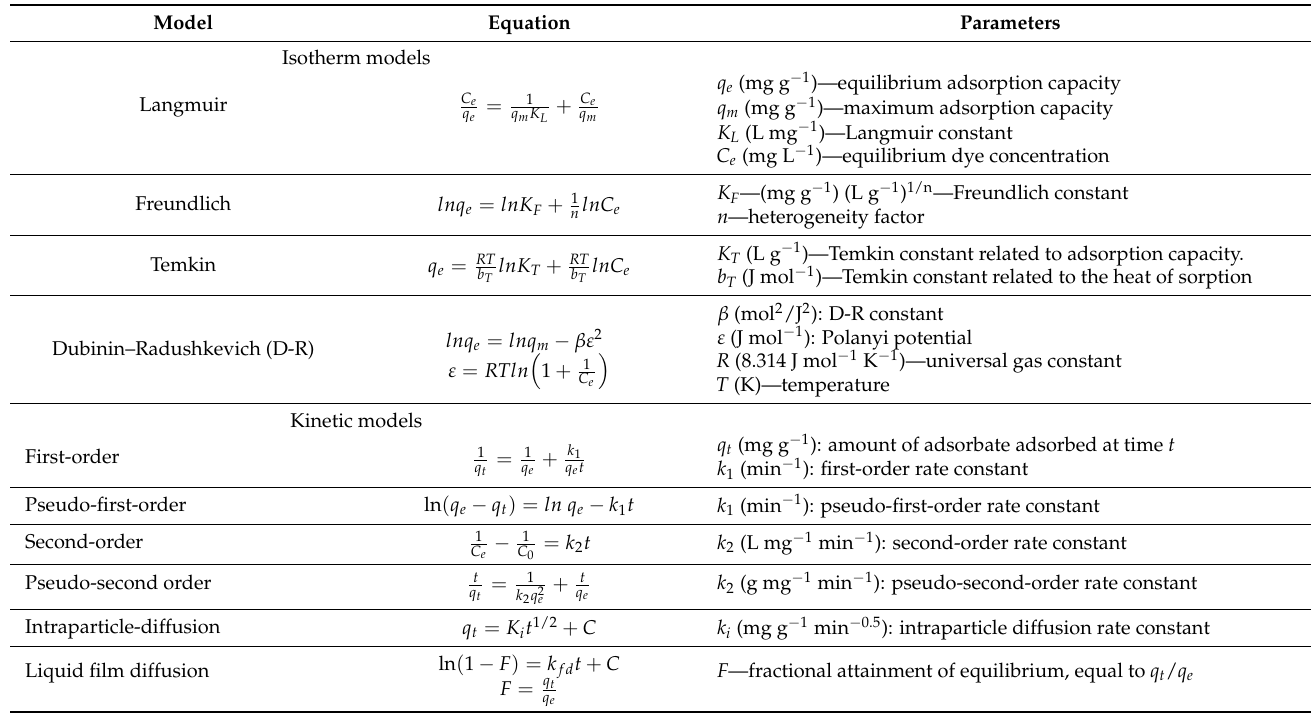
Table 1. Isotherm, kinetic, and other equations used in this